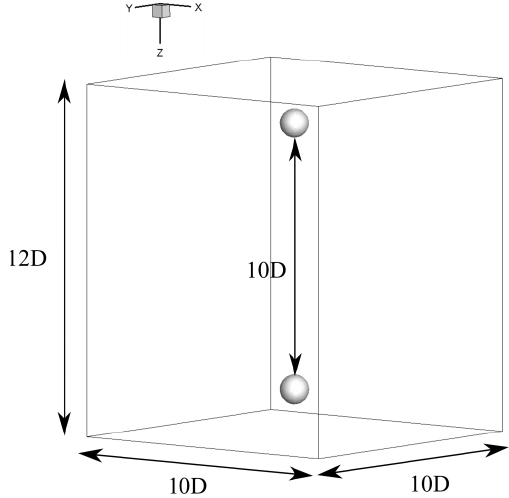
Figure 14. Computational domain of the particle – particle collision simulation.